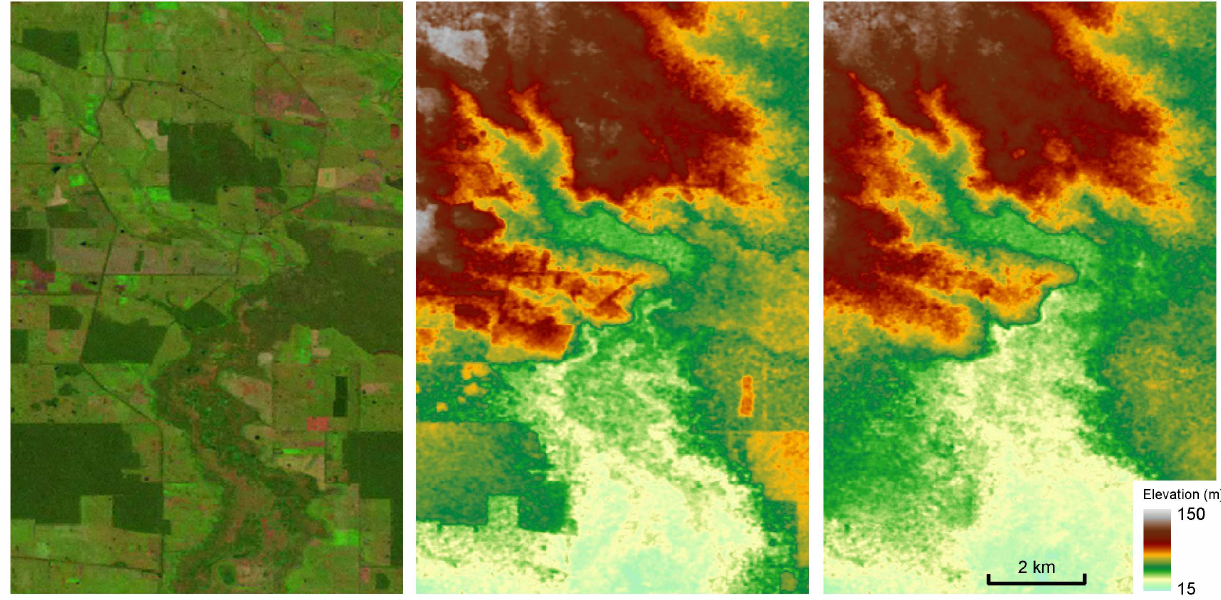
Figure 1. Landsat image (left), digital surface model (DSM, centre) and bare earth digital elevation model (DEM, right) near Milltown, Victoria, 141.78°E